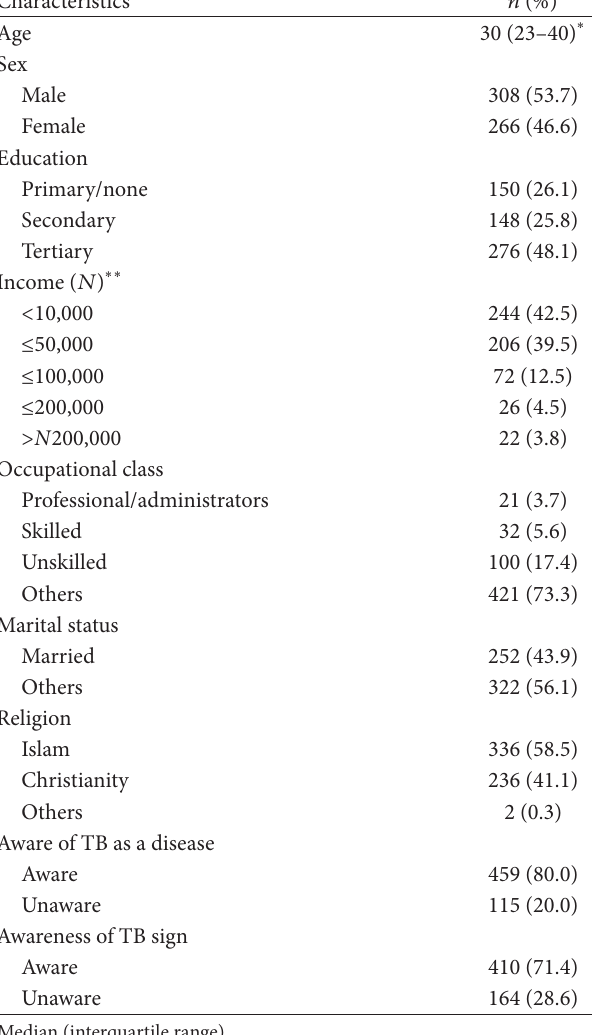
T 3: Predictors of warning signs of TB.